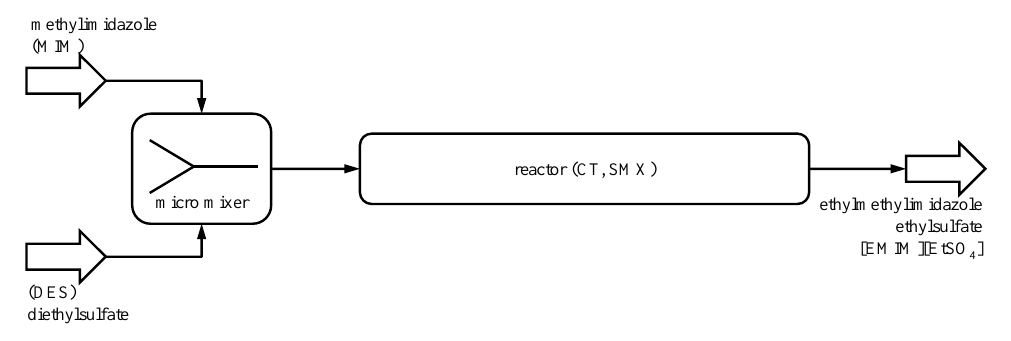
Figure 5. Flowsheet of the example process plant: micromixer to initially mix the reactants; CT or SMX reactor for the main conversion.